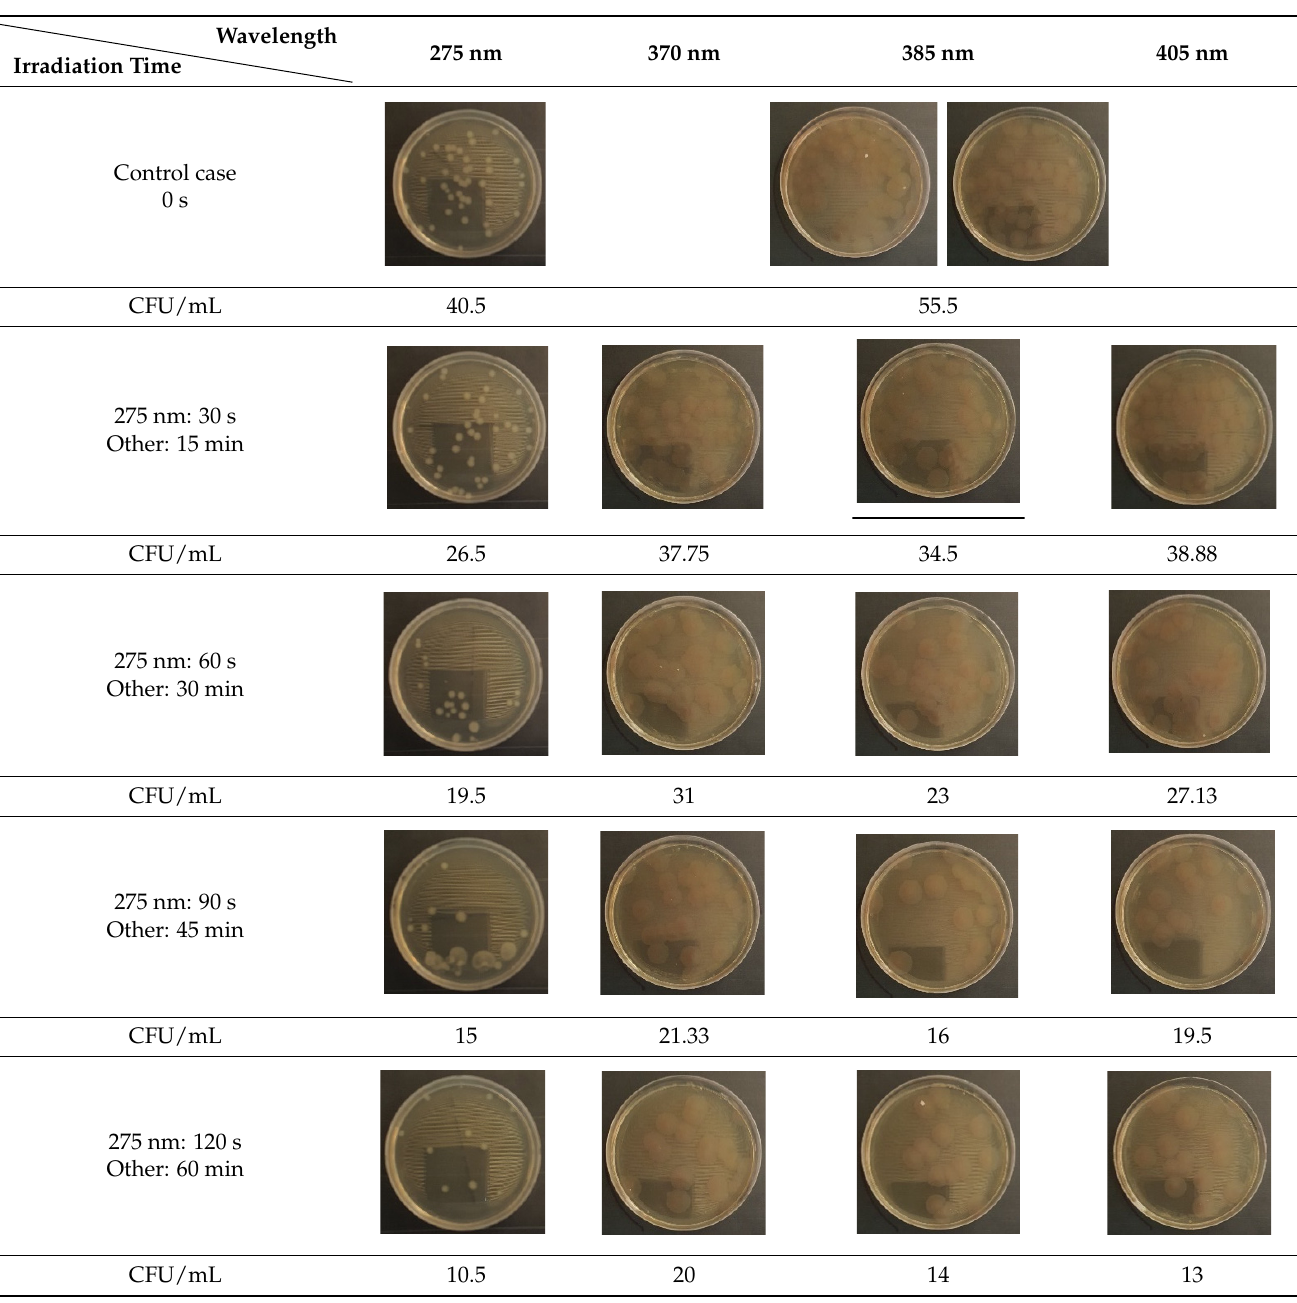
Table 4. Numbers of B. subtilis colonies by wavelength and irradiation time.